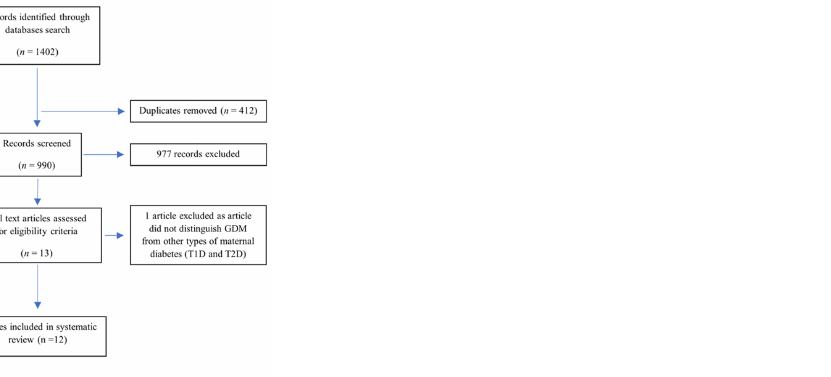
Figure 1. PRISMA diagram of the studies of the systematic search and studies included. GDM, ges- tational diabetes mellitus; T1D, type 1 diabetes; T2D, type 2 diabetes.